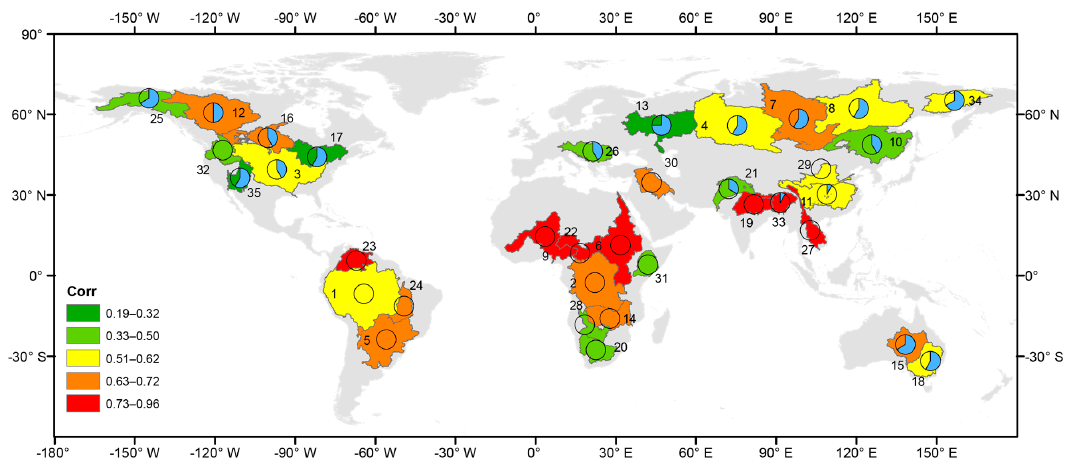
Figure 1. Map of the 35 river basins, numbered in decreasing basin area and colored by correlation between basin-averaged cumulative P residuals and total water storage anomalies (TWSA). Pie charts indicate lags (clockwise) between cumulative P residuals and TWSA, which are normalized by 12. Zero-lags are shown as clear circles. Basin numbers correspond to basin IDs in Table 1. The actual correlation values and lags are reported under P -TWS Corr and P -TWS Lag columns in Table 1.